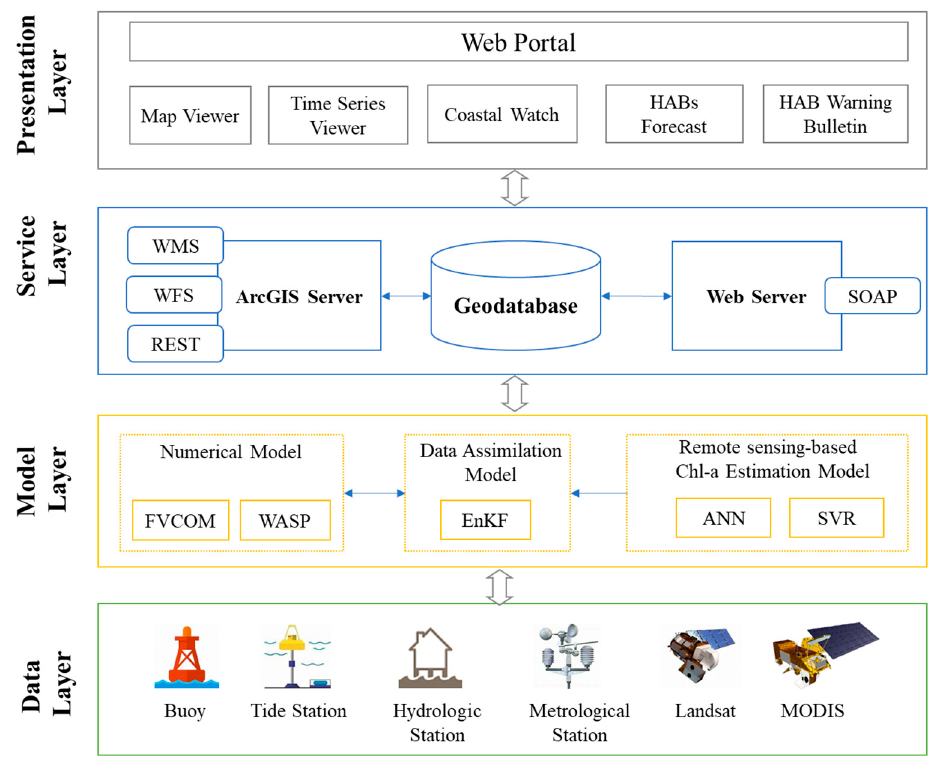
Figure 2. System architecture. Abbreviations: WMS: Web Map Service; WFS: Web Feature Service; WASP: Water Analysis Simulation Program; SOAP: Simple Object Access Protocol; HAB: Harmful algal bloom; FVCOM: Finite-Volume Community Ocean Model; EnKF: Ensemble Kalman Filter; ANN: Artificial Neuronal Network; SVR: Support Vector Regression; MODIS: Moderate-Resolution Imaging Spectroradiometer; REST: Representational State Transfer.